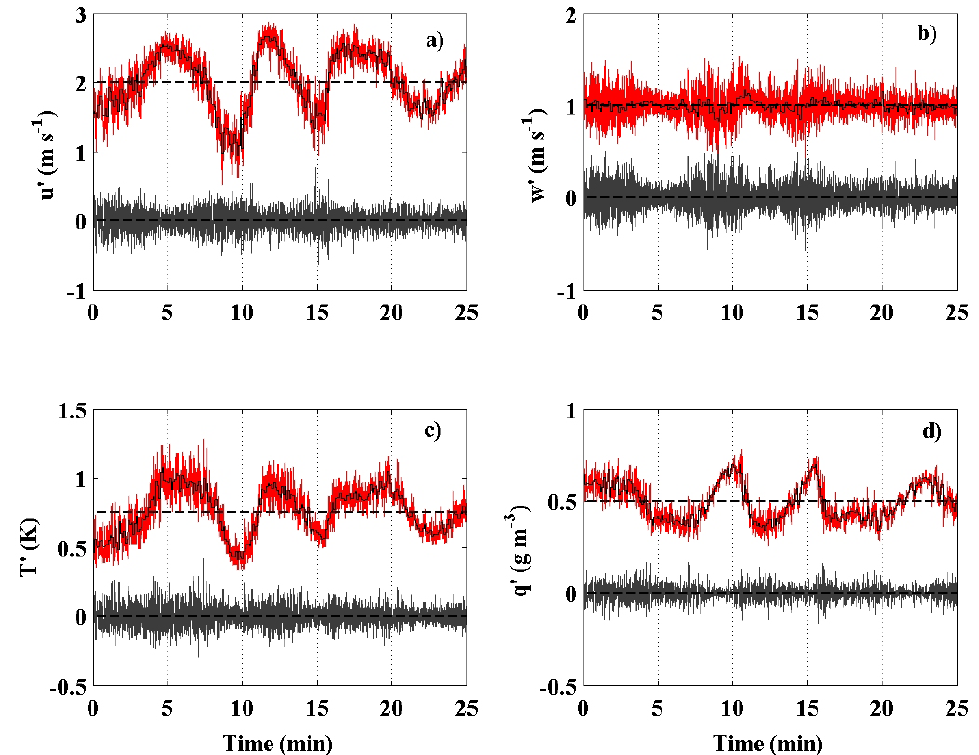
Figure 8. Triple decomposition of longitudinal ( a ) and vertical wind velocity components ( b ), sonic anemometer temperature ( c ) and water vapour concentration ( d ) relative to the case of the “cleaner” gravity wave shown in Figure 2 (Wave 1) and sampled at the highest level (10 m). The time series were filtered using the MR decomposition technique based on the Haar wavelet. The threshold frequency used to separate wavy and turbulent components ( f ~0.01 Hz) was selected on the basis of the spectral analyses shown in ( ) Figures 4 and 5. The red lines represent the original fluctuations x x − , the black lines represent the filtered wavy components , and the grey lines represent the wave- corrected fluctuations . Note that red lines have been artificially shifted for better visualisation